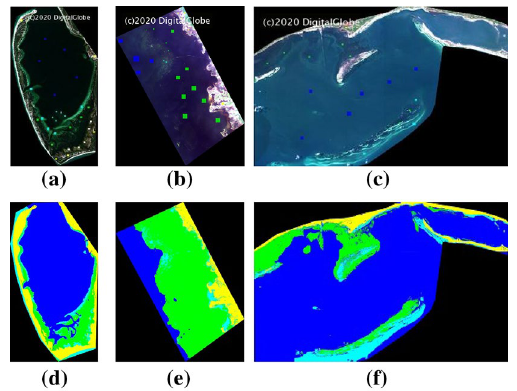
→ → green, sea → magenta. Physics